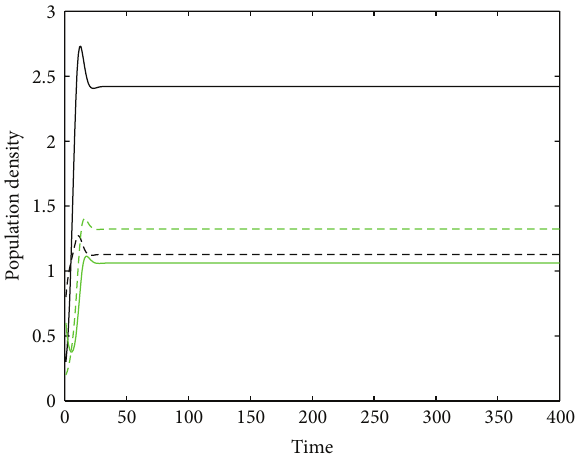
Figure 2: Permanence of model (32). The black solid (dotted) line is the population variation of the prey in patch 1 (patch 2). The green solid(dotted)lineisthepopulationvariationofthepredatorinpatch 1 (patch